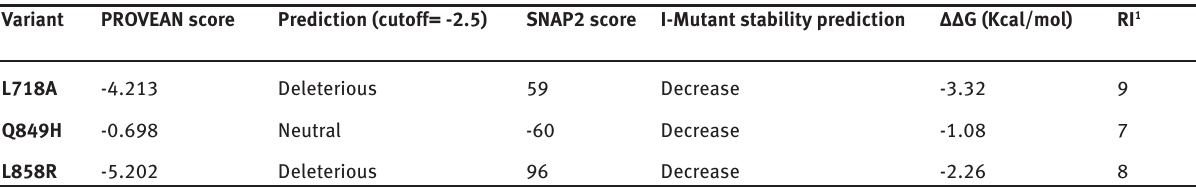
Table 1: Evaluation of mutation effects on EGFR. Variant PROVEAN